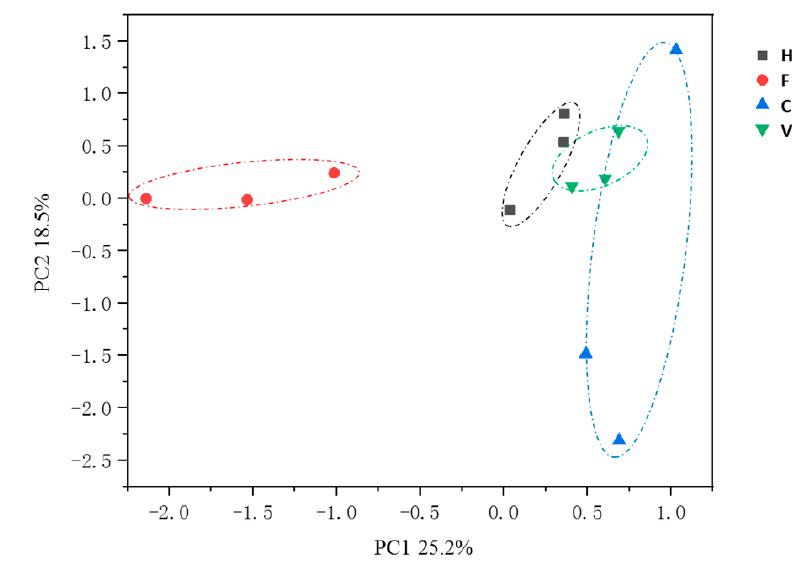
Figure 3. The heat map of detected ARGs. H: hospital; F: farm; C: city residence; V: village residence. MLSB: macrolide–lincosamide–streptogramin B resistance.